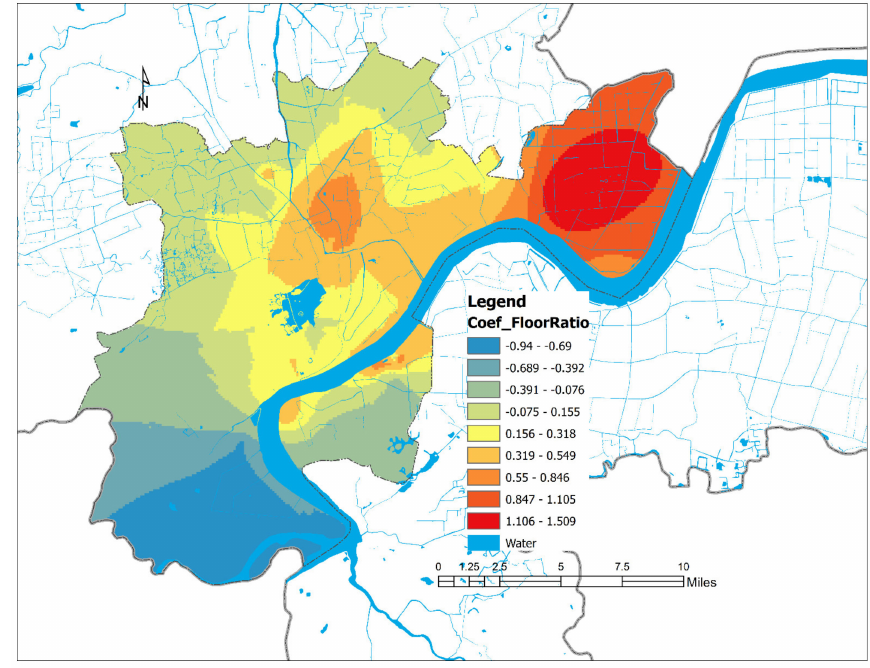
Figure 12. Floor ratio regression coefficient diagram of commercial land category